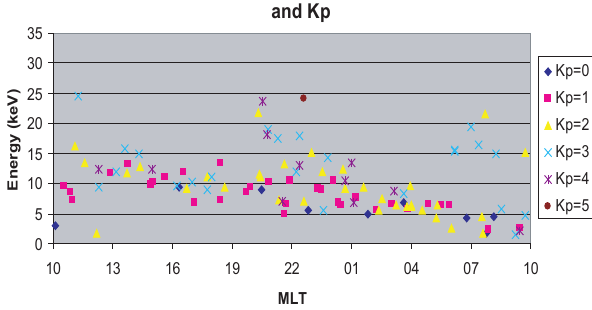
Characteristic energy of the first nose as a function of MLT and Kp